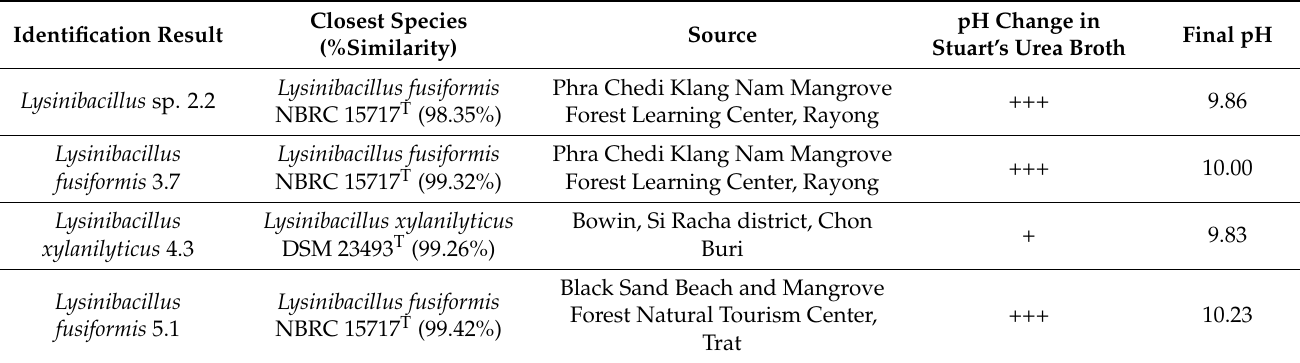
Table 1. Identification results based on the 16S rRNA gene sequence similarity and the positive results of Stuart’s urea broth.